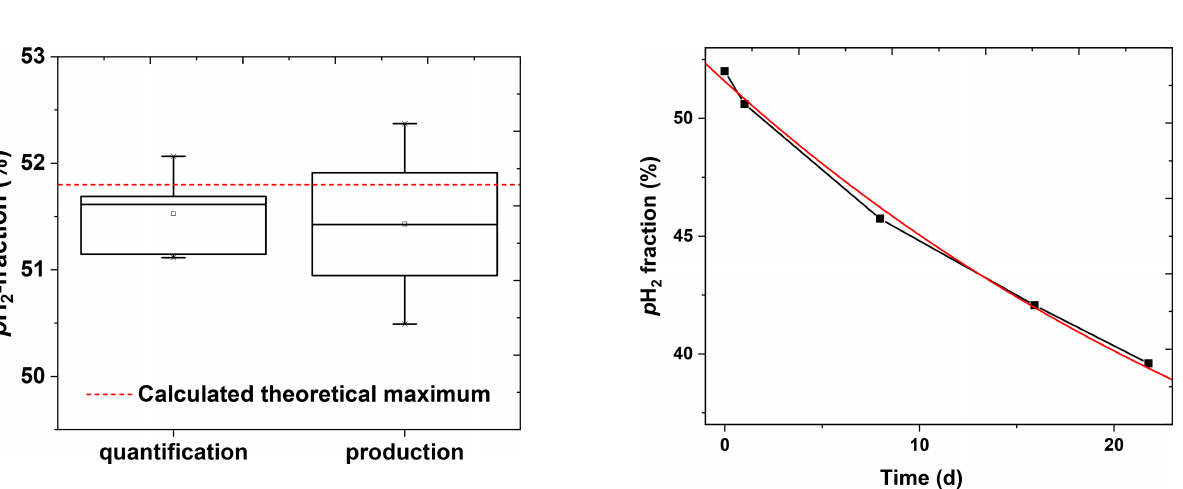
Figure 7. PHG operating parameters and NMR spectra: (a) pressure p out and calculated flow rate f c r = p (cid:48) out · V 0 T stand for input pressure p in = 50 bar and V 0 = 1L, (b) 1 H NMR spectra of rtH 2 , p H 2 and N 2 to quantify f p H (Eq. 3). For the latter, the para-enrichment was found to be constant up to a flow rate of f r = 2SLM (for p in = 20 bar, p target = 10 bar).